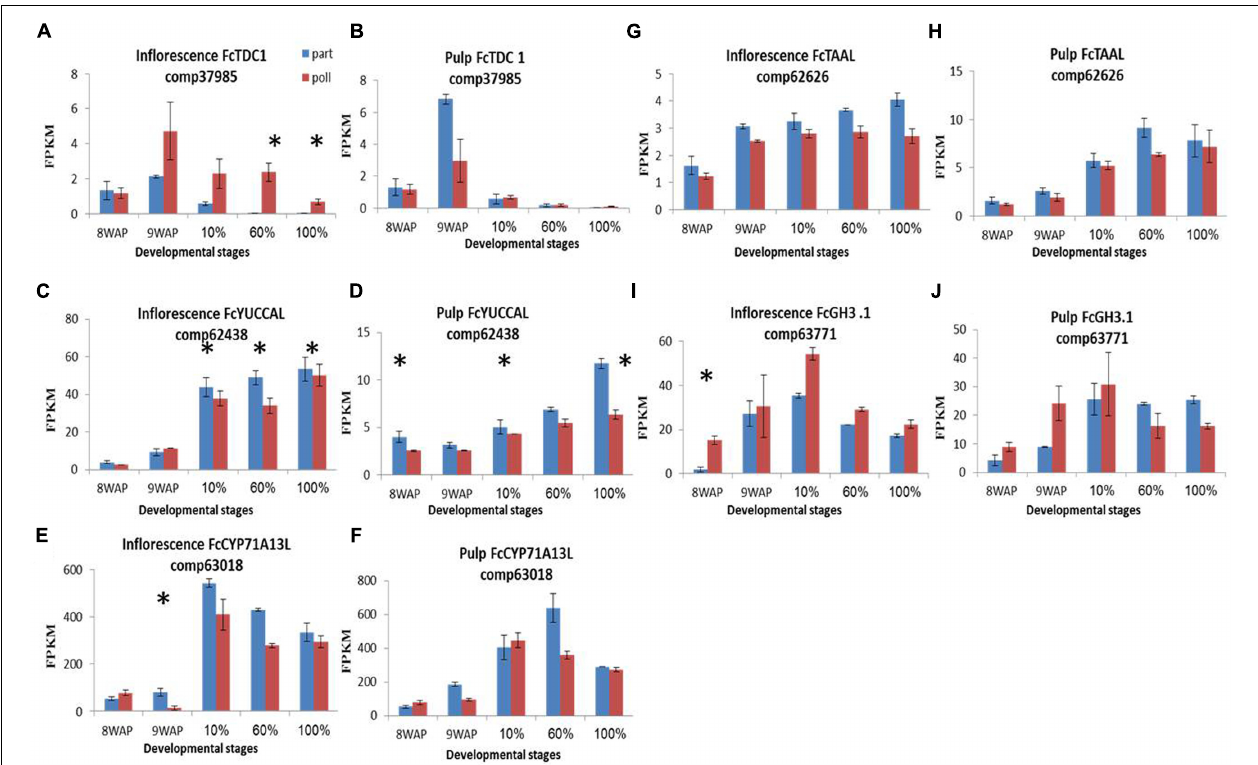
FIGURE 5 | Gene-expression pattern of five predicted IAA-metabolism genes. Genes were idenitfied by tblastn of the IAA-biosynthesis genes from Arabidopsis thaliana against our Ficus carica (Fc) data and validate against Malus and the NCBI databases. (A,B) Expression levels of Fc TDC1 in inflorescence and pulp, respectively. (C,D) Expression levels of Fc YUCCAL in inflorescence and pulp, respectively. (E,F) Expression levels of Fc CYP71A13L in inflorescence and pulp, respectively. (G,H) Expression levels of Fc TAAL in inflorescence and pulp, respectively . (I,J) Expression levels of Fc GH3.1 in inflorescence and pulp, respectively. Bars represent standard error. Asterisk represent statistical significance determined using the edgeR test (FDR <